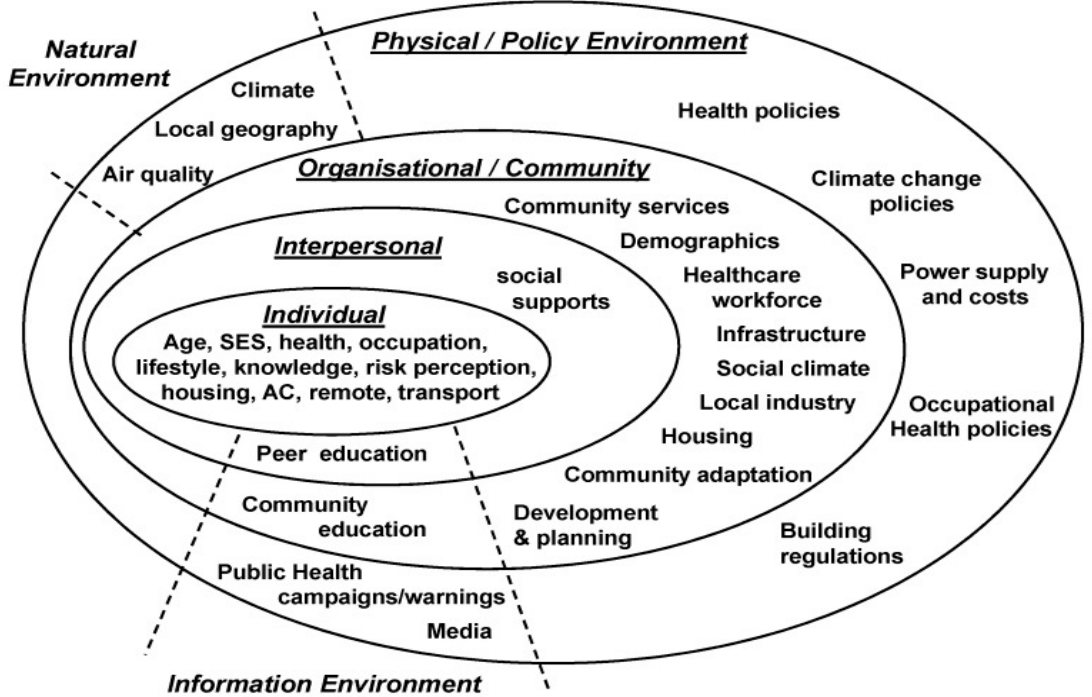
Figure 2. Factors influencing heat adaptation [88].